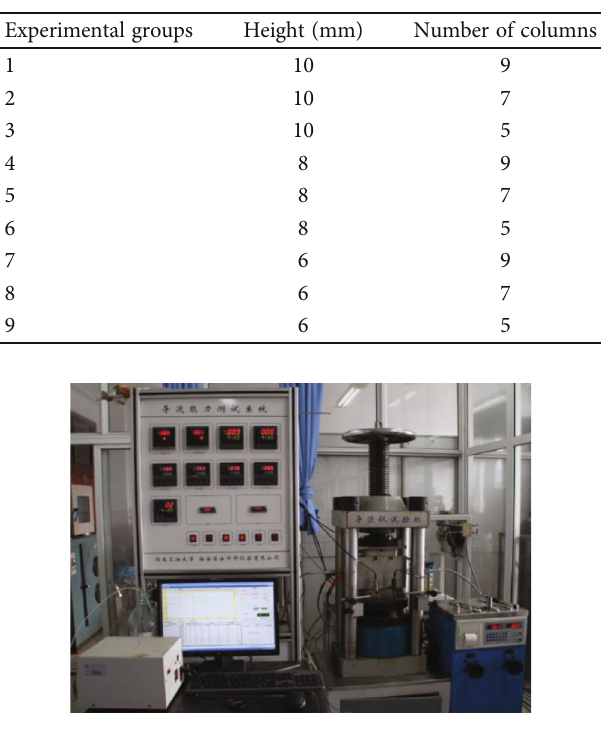
Figure 2: Fracture conductivity testing and analysis